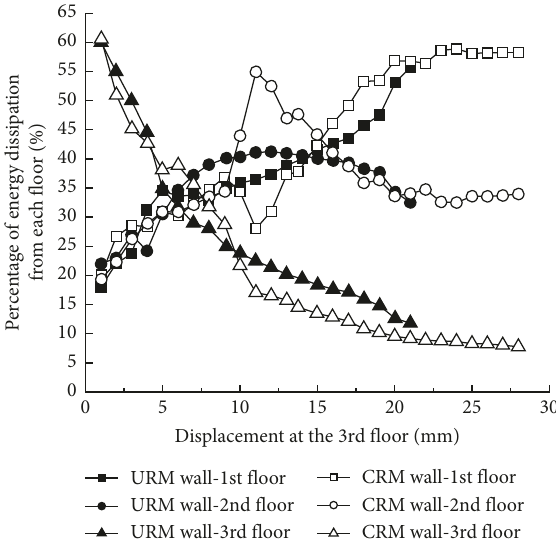
Figure 15: Percentage of energy dissipation from each